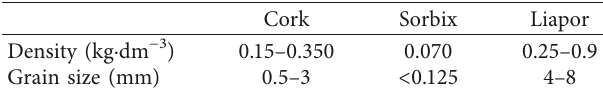
Figure 1: Floating supports (from the left cork, Sorbix, and Liapor) and demonstration of their stability on water Table 1: Properties of the floating substrates.